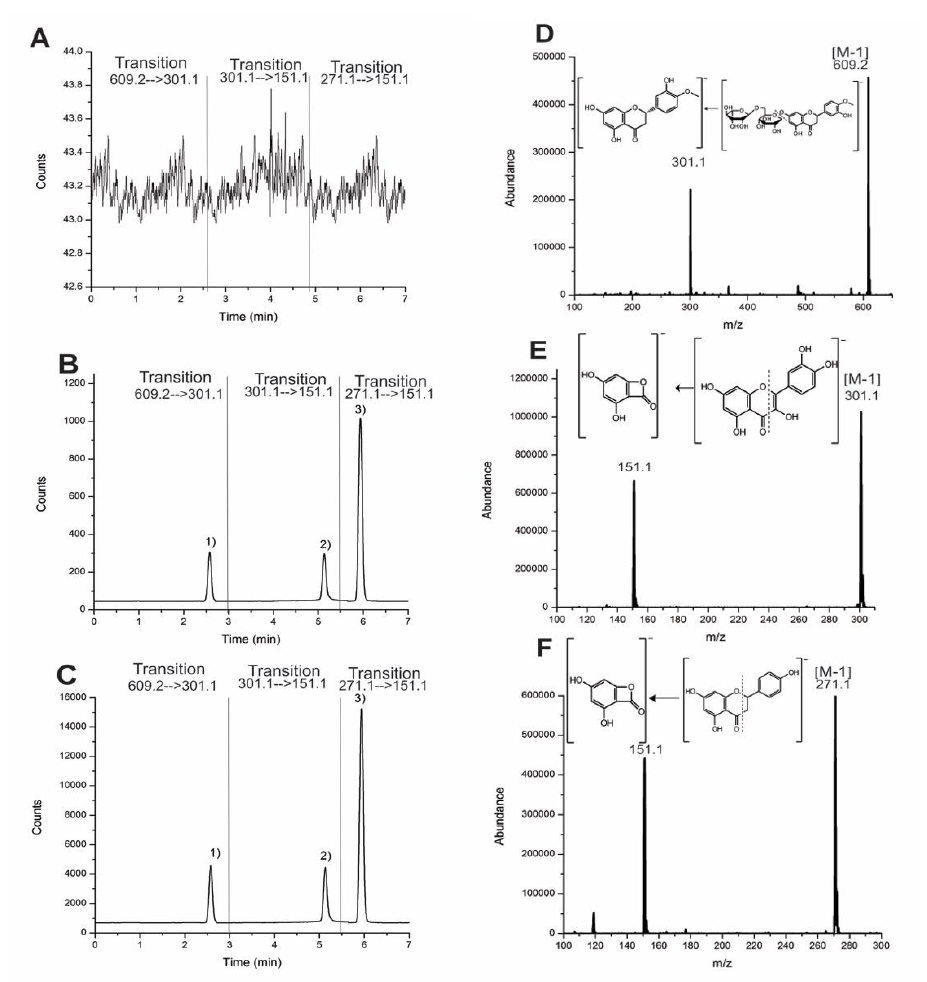
Figure 2. Comparison between ( A ) blank plasma chromatogram, ( B ) central point, and ( C ) optimal point. Chromatograms and mass spectra with transition at 10 ng/mL: (1) Hesperidin ( D , 2.58 min), (2) quercetin ( E , 5.13 min), and (3) naringenin ( F , 5.93 min).